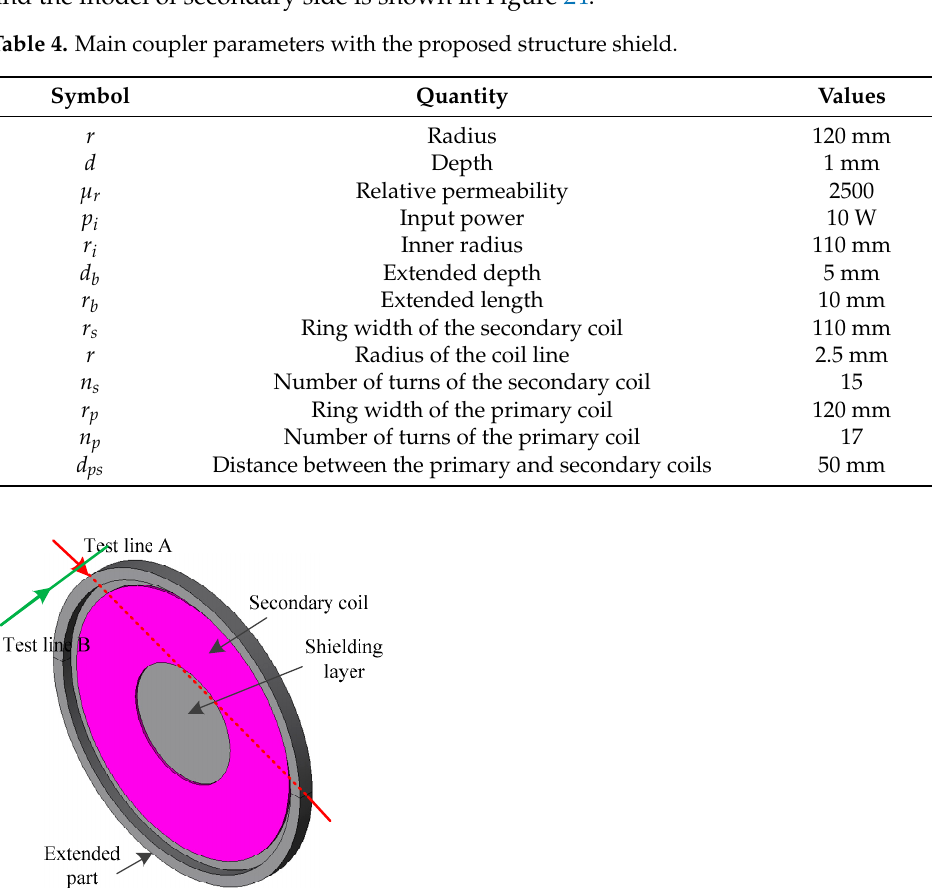
Figure 23. Physical dimensions of the shields. ( a ) Conventional structure. ( b ) Proposed structure.